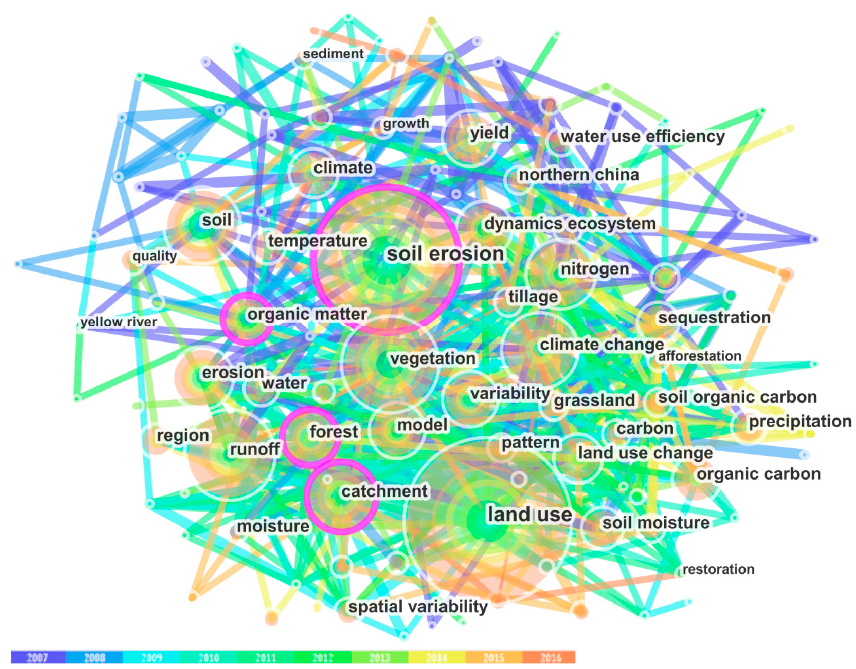
Figure 4. The bibliometric network map of keywords based on SCI literature from 2007–2016. Table 3 ． Annual distribution of the main research topics of the CNKI literature from 2007–2016.